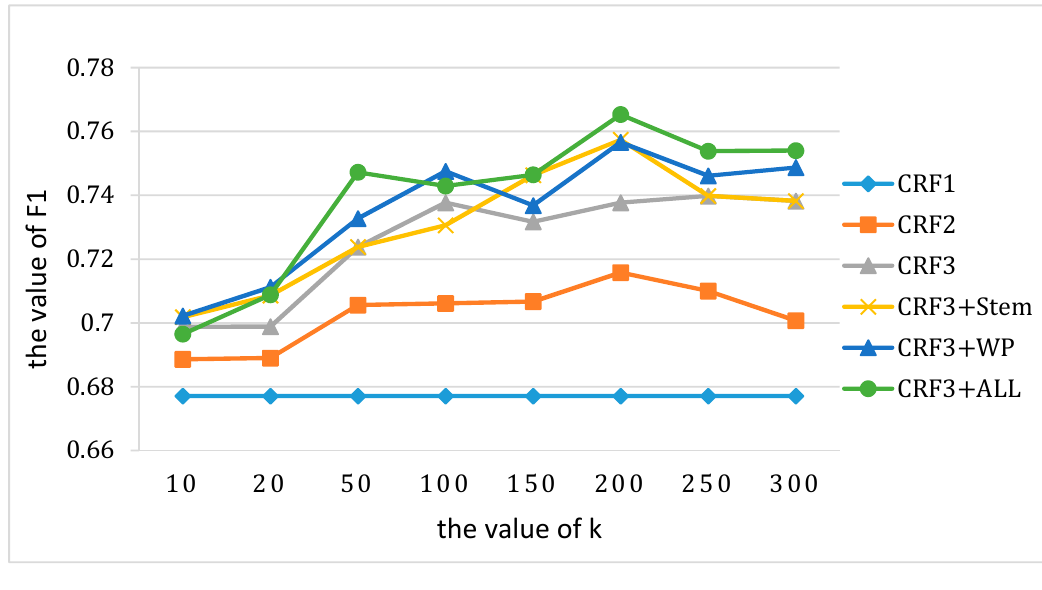
Figure 3. The effect of K on experimental results (R-14). Information 2018 , 9 , x FOR PEER REVIEW